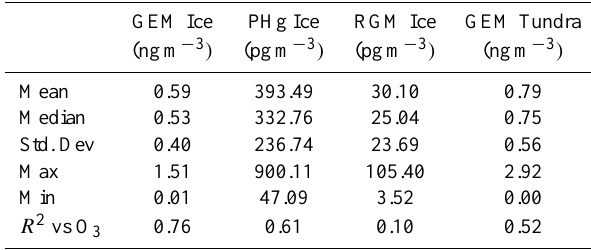
Table 1. Mercury concentration data descriptive statistics from measurements over the sea ice and